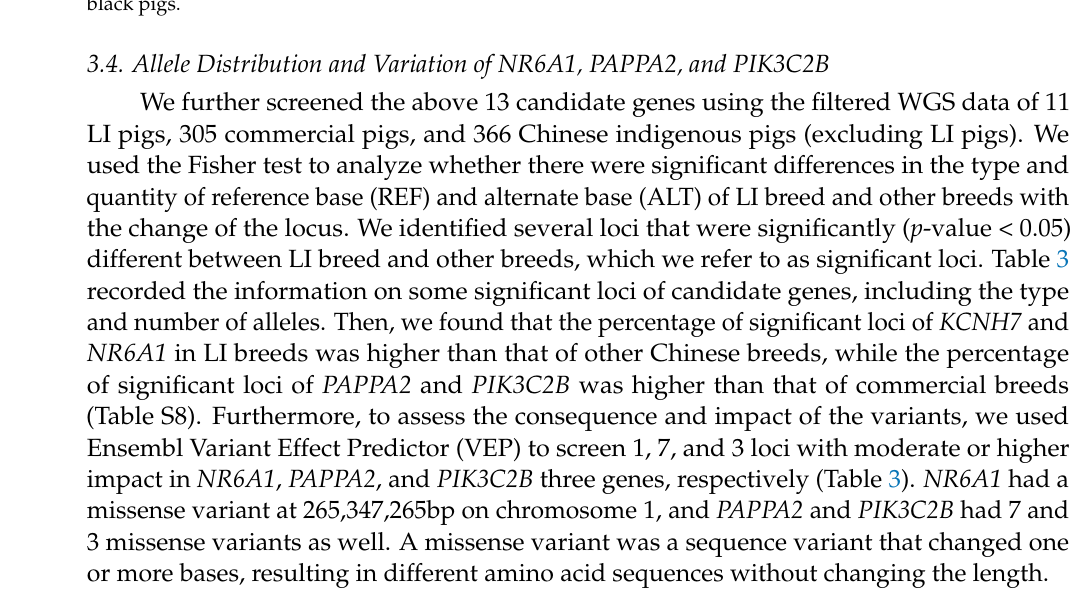
Table 3. Base distribution, VEP variants type, and amino acid transformation of